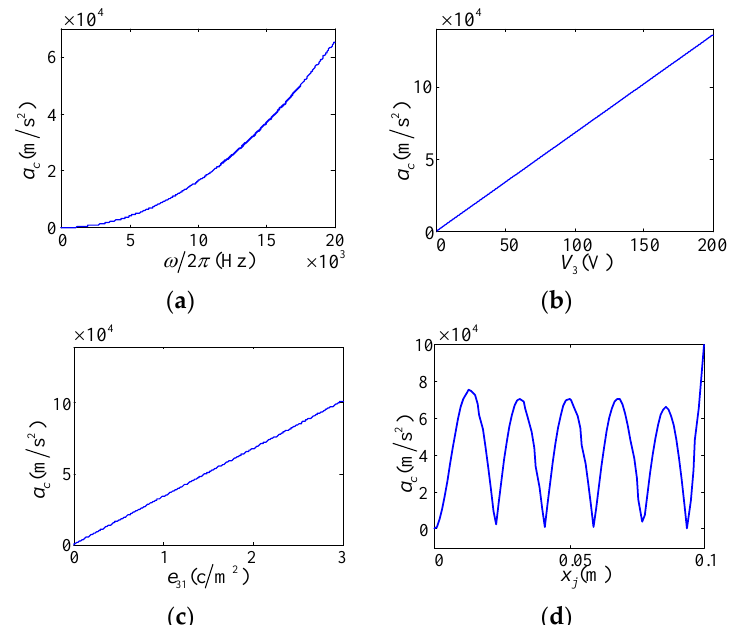
Figure 11. Image of the vibration acceleration of the ciliary-like body and its parameters. ( a ) a c - ω image of ciliary-like body; ( b ) a c - V 3 image of ciliary-like body; ( c ) a c - e 31 image of ciliary-like body; ( d ) a c -x j image of ciliary-like body.